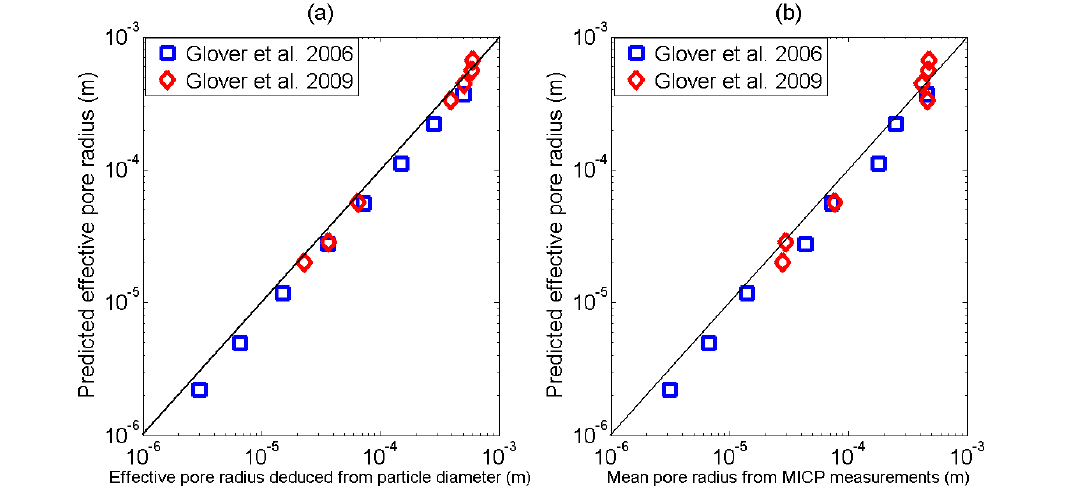
Figure 9. Comparison of predicted and measured effective pore radii for a set of glass bead packs reported in [94,96]. ( a ) Predicted effective pore radius given by Equation (46) against the pore radius associated with the grain diameter given by Equation (47). ( b ) Predicted effective pore radius given by Equation (46) against the mean pore radius from MICP measurements reported in